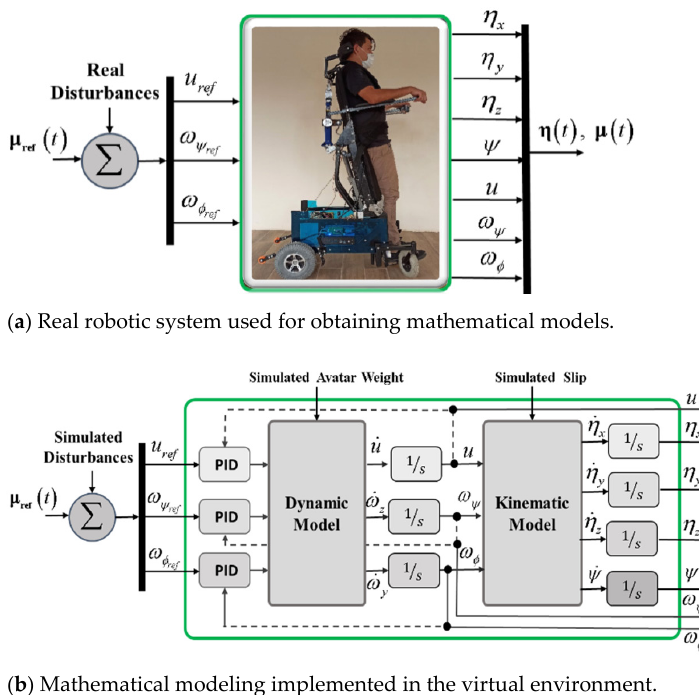
Figure 9. Cinematic and dynamic behavior of the human–robot system.